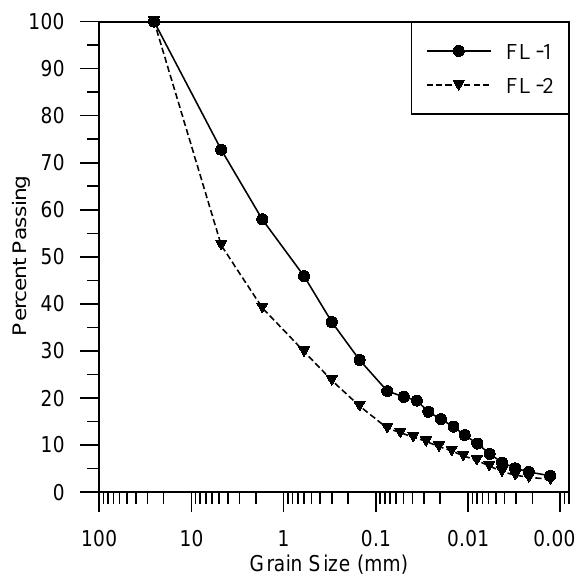
Figure 8. Grain size distribution of two sediment samples taken from the top portion of the front lobe of